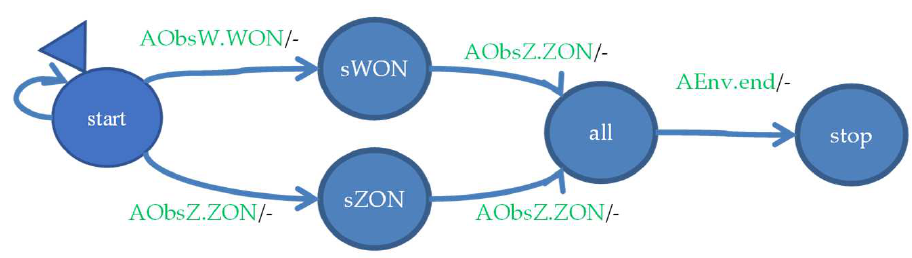
Figure 9. Observer